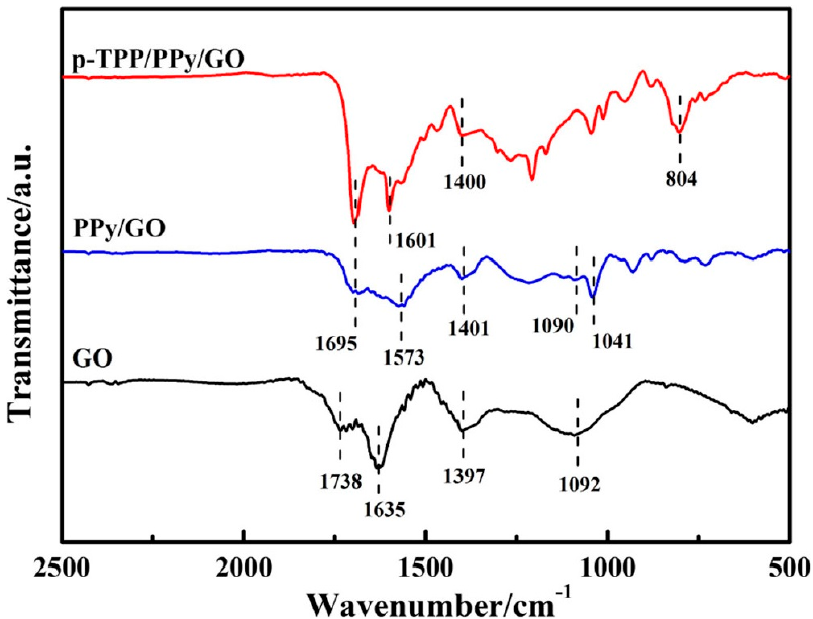
Figure 2. FTIR spectra of the compounds: GO (black curve), PPY/GO (blue curve), and p- TPP/PPY/GO (red curve). Reproduced with permission from ref. [5]; Copyright 2022 Springer.